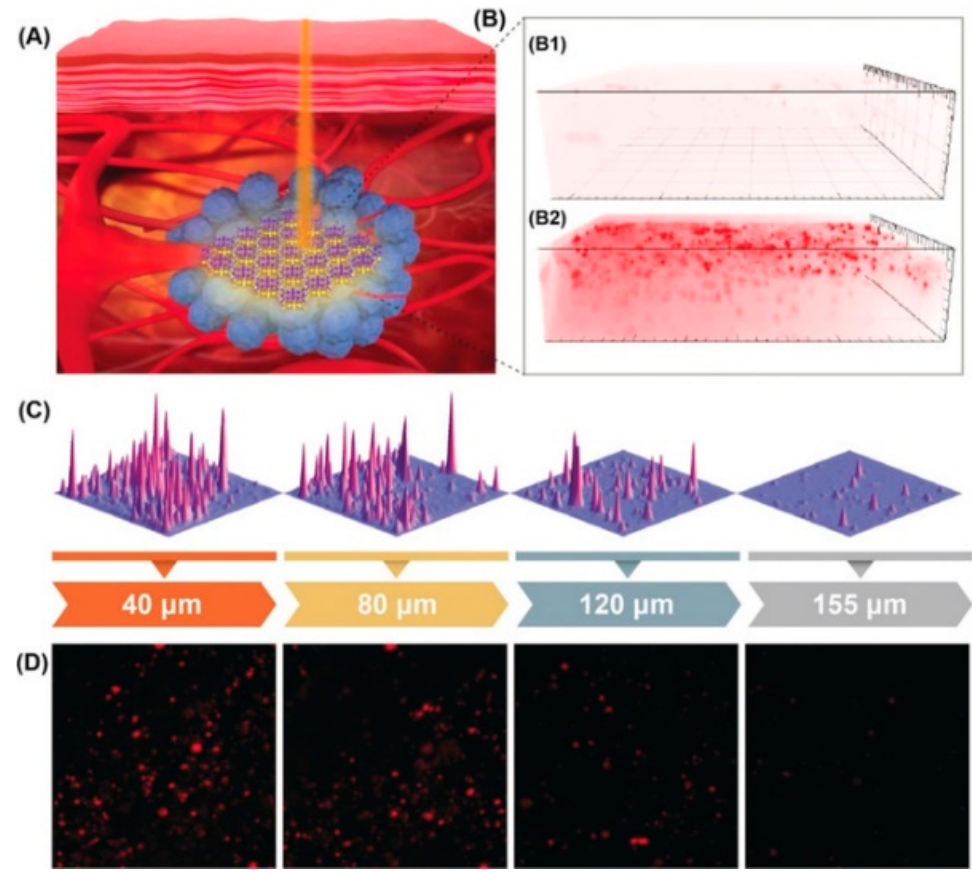
Figure 3. ( A ) Schematic diagram of TPI-COF for in vivo tumor imaging. ( B ) The two-photon induced fluorescence imaging study of TPI-COF in Balb/c mice model with 4T1 tumor xenograft (B1, PBS group; B2, TPI-COF group). ( C ) The two-photon fluorescence intensity of TPI-COF at different tumor tissue depths. ( D ) The two-photon fluorescence imaging of TPI-COF at different tumor tissue depths. Reprinted with permission from [61]. Copyright 2019 John Wiley and Sons.